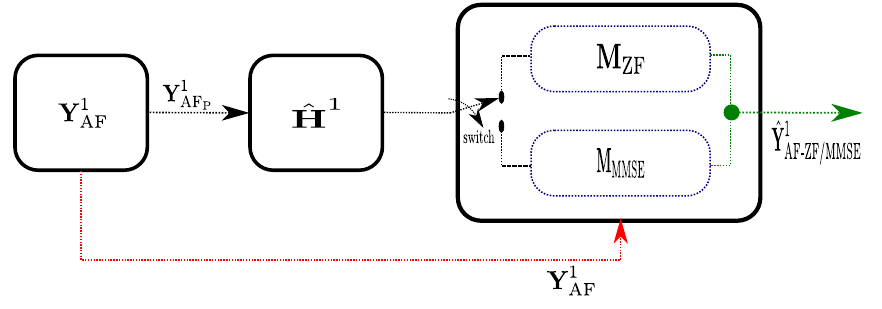
Figure 3. Pre-Equalization Schemes.